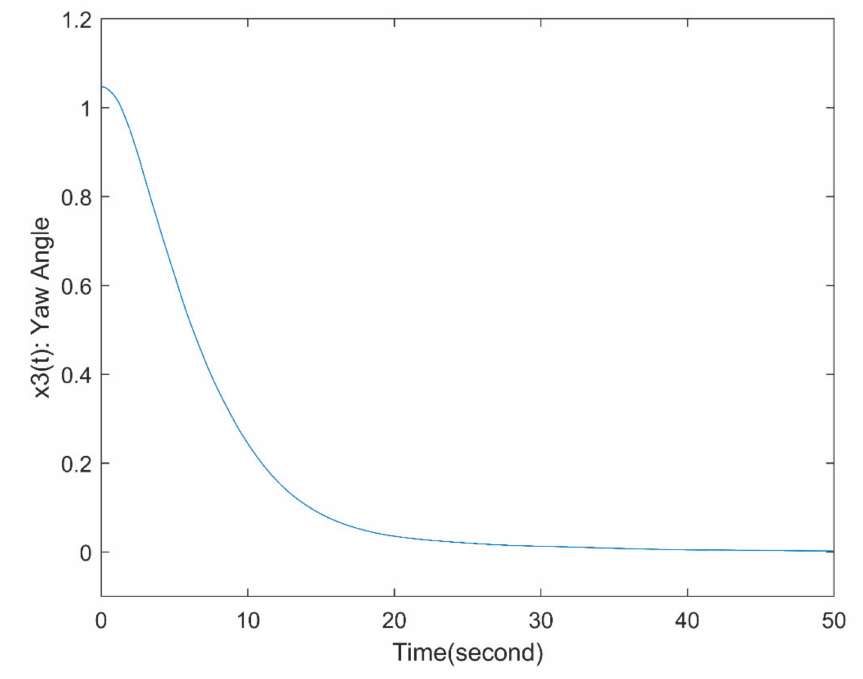
Figure 4. Response of state x 3 ( t ) .